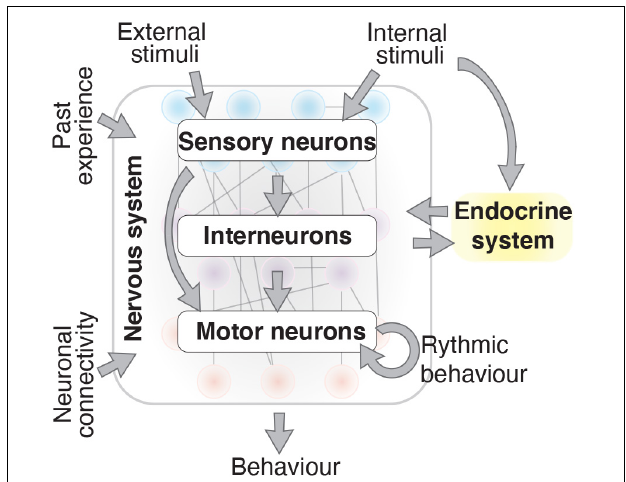
FIGURE 1 | Behavior results by integrating numerous factors. The nervous system produces behavior that is influenced by external and internal stimuli, past experience, neuronal connectivity, and the endocrine system. Information flows from sensory neurons to interneurons and motor neurons through synaptic and gap junction connections and neuropeptide secretion. Consistent rhythmic behaviors, produced by motor neurons, are also influenced by the physiological state of the nervous system caused by internal and external